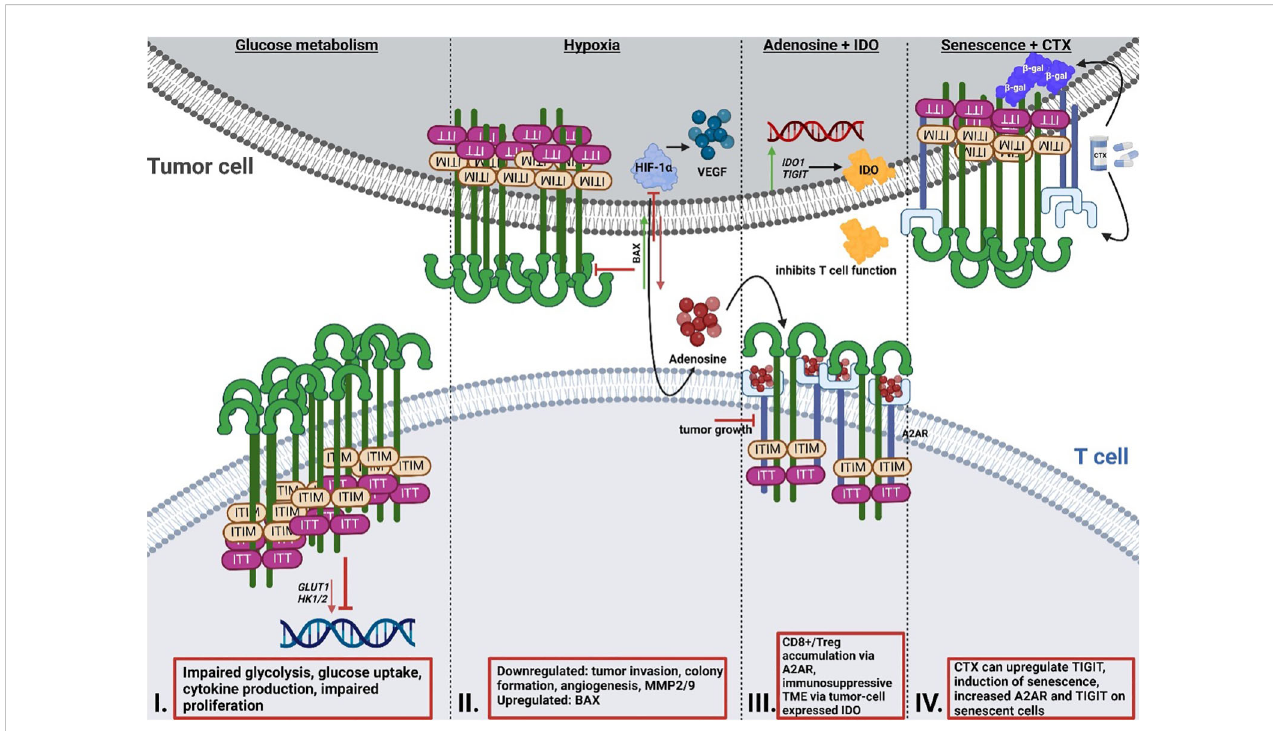
FIGURE 2 Reciprocal interaction of TIGIT signaling and T cell metabolism. I : Effect of TIGIT on glucose metabolism. Cancer cells inhibit T cell metabolism via enhancing the upregulation of TIGIT, resulting in impaired glycolysis gene expression of GLUT1 and HK1/2 , glucose uptake and glycolysis, and reduced proliferation. II : Effect of TIGIT on hypoxia and hypoxia sensing. HIF1- a regulates the expression of immune checkpoints and the expression of VEGF, which mediates tumor neovascularization. Simultaneous blocking of HIF1- a and TIGIT results in reduced tumor invasion and colony formation, as well as impaired angiogenesis and reduced MMP2/9 expression. Dual blockade leads to induction of pro-apoptotic BAX. III : Interaction of TIGIT and adenosine signaling and IDO. A2AR regulates the accumulation of CD8+ T cells and Tregs. Altered metabolism and hypoxia result in increased adenosine in the TME. Deletion of A2AR leads to tumor rejection in mice. IDO is highly expressed by tumor cells and generates an immunosuppressive TME. Many cancer cells overexpress IDO1 and TIGIT simultaneously. IV : Interaction of chemotherapy and senescence and TIGIT. Chemotherapy regimens can result in the upregulation of TIGIT. A2AR is increased on the surface of senescent cells, with simultaneous upregulation of TIGIT. TIGIT, T cell immunoglobulin and ITIM domain; HK, hexokinase; GLUT1, glucose transporter 1; HIF1- a ; hypoxia-inducible factor 1 alpha; MMP, matrix metalloproteinase; BAX, Bcl-2- associated X protein; IDO, indoleamine-pyrrole 2,3-dioxygenase; TME, tumor